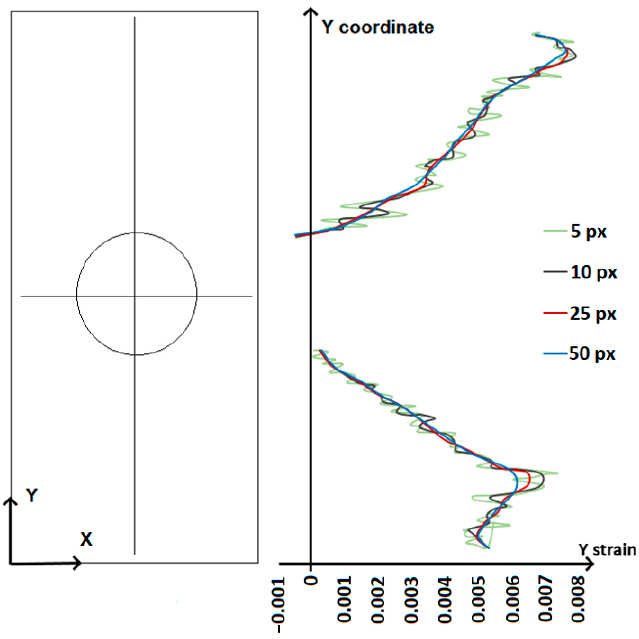
Figure 1. Plot (replicated from [12–14]) of the DIC evaluated strain for a plate with hole loaded in tension for various values of the DIC step.